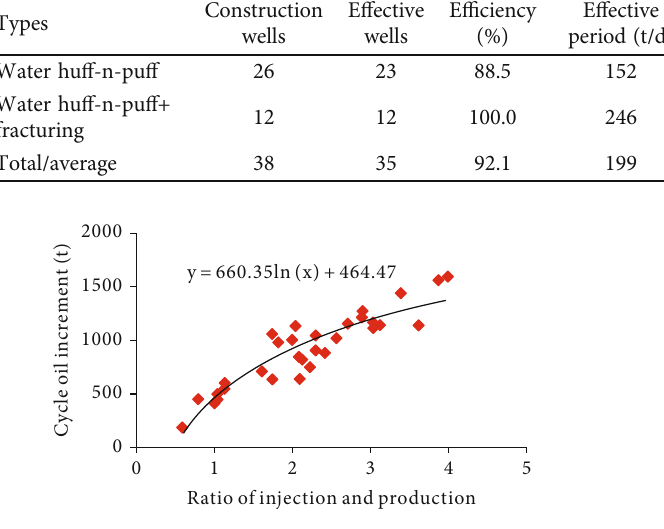
Figure 5: Fitting curve between cycle oil increasing and injection- production ratio in water hu ff -n-pu ff .